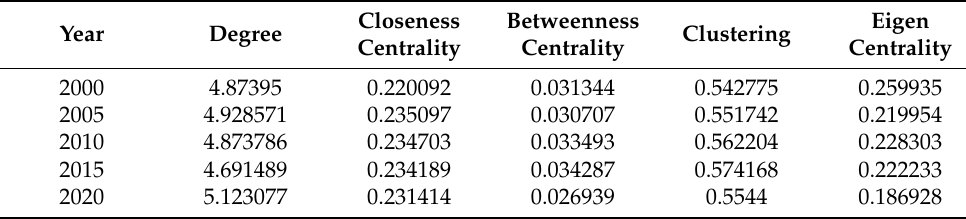
Table 2. Average topological values of ecological spatial networks in 2000–2020.